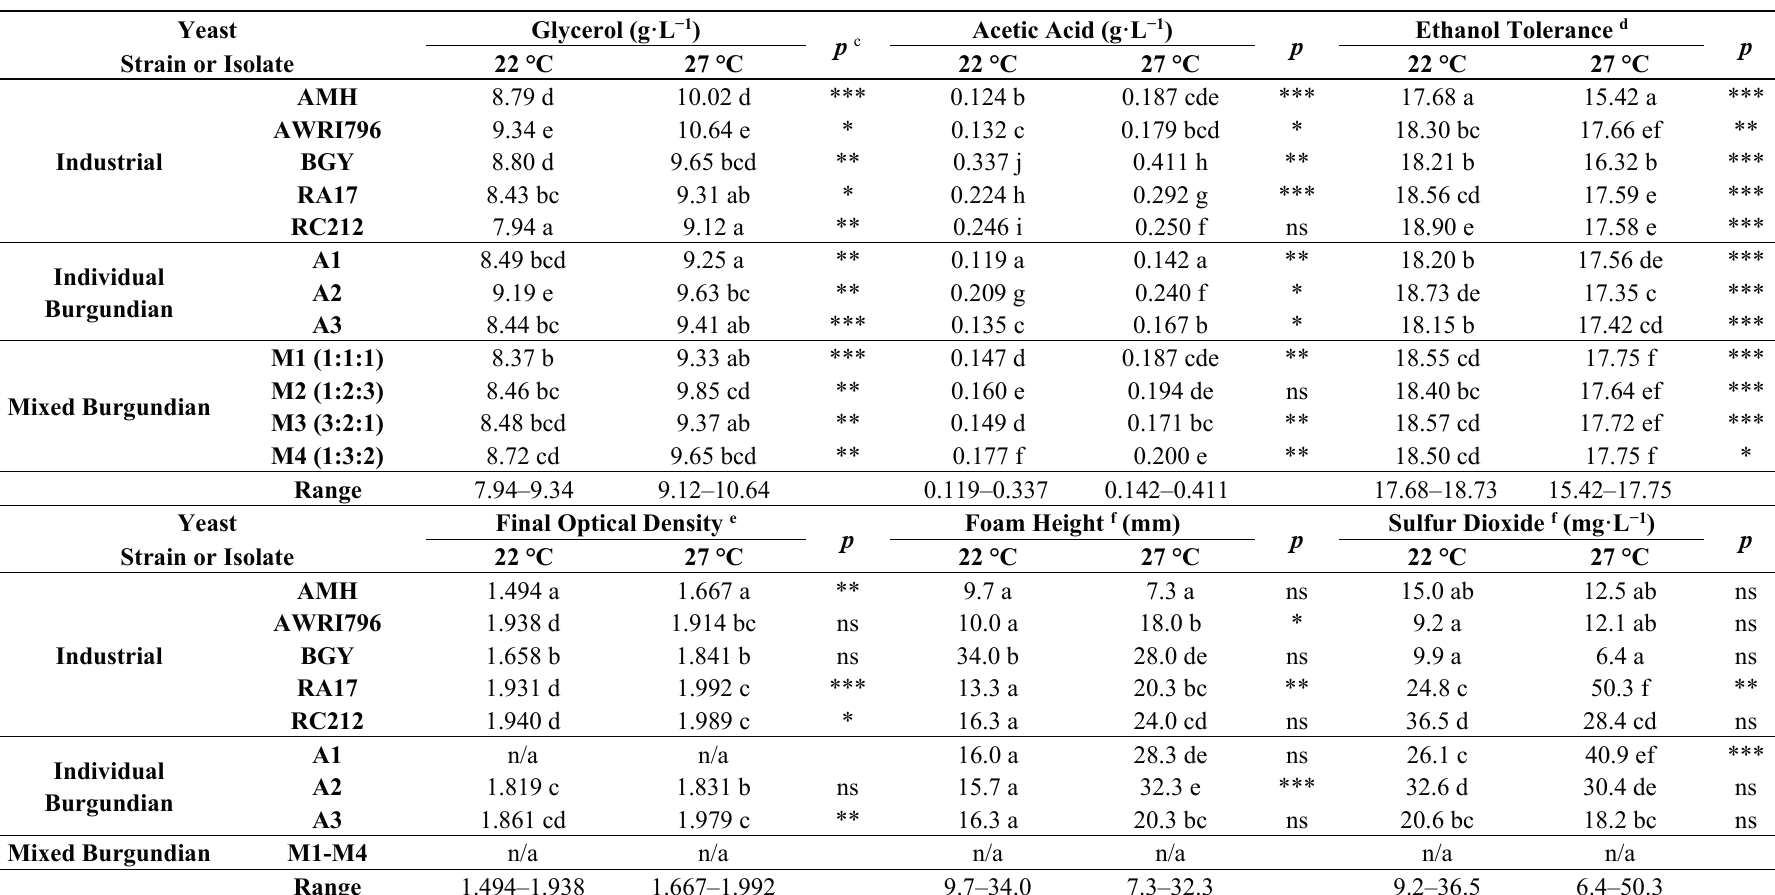
Table 1. Mean a,b enological characteristics (glycerol, acetic acid, ethanol tolerance, final optical density, foam height, sulfur dioxide) for Pinot noir fermented with industrial strains and individual- and mixed-Burgundian S. cerevisiae isolates, at 22 °C and 27 °C. For each determination, strain and temperature effects are shown with subscripts and p values,